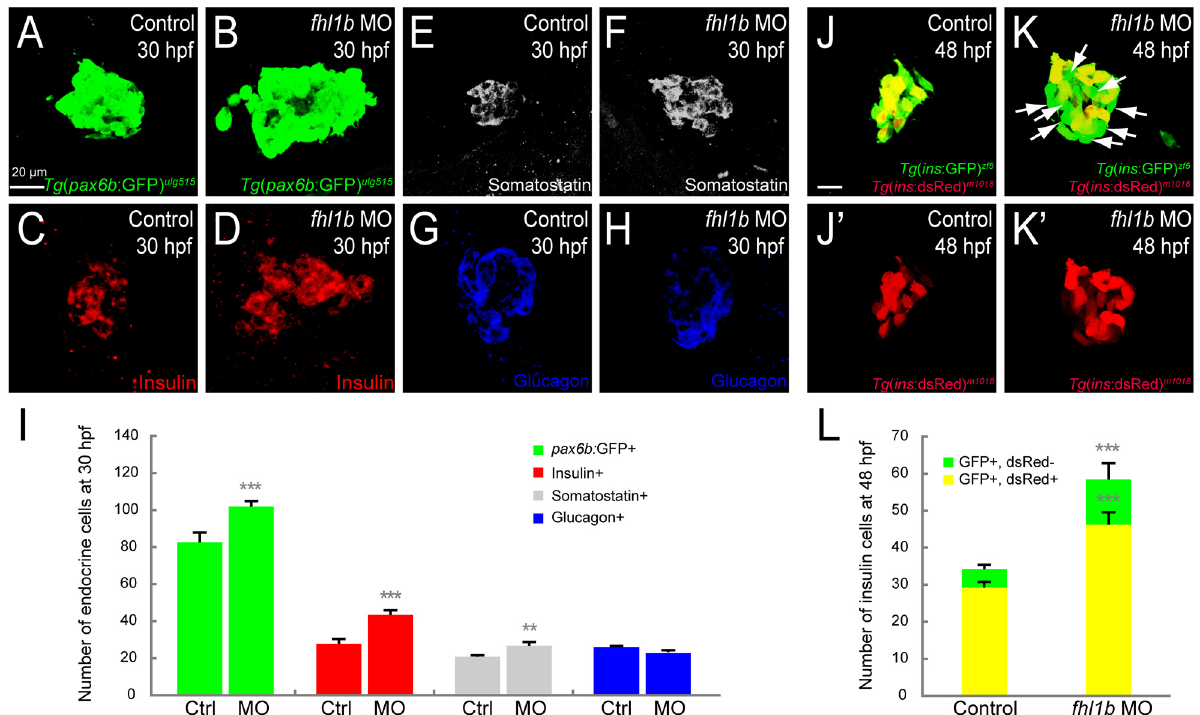
Fig 3. Decreased Fhl1b activity augments induction of pancreatic endocrine cells. (A-H) Confocal images showing Tg(P0-pax6b :GFP ) ulg515 (A and B, green), Insulin (C and D, red), Somatostatin (E and F, grey), and Glucagon (G and H, blue) expression at 30 hpf, comparing control embryos (A, C, E, and G) and fhl1b morphants (B, D, F, and H). The number of Tg(P0-pax6b :GFP ) ulg515 (B)- and Insulin (D)-expressing cells was significantly increased in fhl1b morphants compared to that of control embryos (A and C, respectively). The number of Somatostatin-expressing cells was also increased (F), while that of Glucagon-expressing cells appeared unaffected (H) in fhl1b morphants compared to that of control embryos (E and G, respectively). (I) Quantification of the number (mean ± SD) of total and individual pancreatic endocrine hormone-expressing cells, comparing that of control embryos and fhl1b morphants at 30 hpf. The absolute number of Tg(P0-pax6b :GFP ) ulg515 -, Insulin-, and Somatostatin-expressing cells was increased from 82.6 ± 4.5, 30.6 ± 1.5, and 20.7 ± 0.8, respectively, in control embryos, to 103 ± 2.0, 44.6 ± 2.0, and 26.7 ± 2.0, respectively, in fhl1b morphants, while that of Glucagon-expressing cells appeared unaffected (26.5 ± 0.7 cells in controls vs. 24.6 ± 1.5 cells in fhl1b morphants). Cells in 20 planes of confocal images from 5 individual embryos were counted. Asterisks indicate statistical significance: ** , P < 0.01; *** , P < 0.001. (J-K ’ ) Confocal images of Tg(ins : GFP) zf5 ;Tg(ins : dsRed) m1018 control embryos (J and J ’ ) and fhl1b morphants (K and K ’ ) at 48 hpf. Compared with the control embryos (J), fhl1b morphants showed an increased number of GFP-only-positive β -cells (K, white arrows). (L) Quantification of the number (mean ± SD) of GFP- and dsRed-double positive (yellow) and GFP-only-positive (green) β -cells, comparing that of control embryos and fhl1b morphants at 48 hpf. In control embryos, 5.0 ± 0.7 β -cells were GFP-only-positive, while 12.2 ± 2.3 β -cells were GFP-only- positive in fhl1b morphants. Cells in 20 planes of confocal images from 5 individual embryos were counted. Asterisks indicate statistical significance: *** , P < 0.001. A-H and J-K ’ , confocal projection images, ventral views, anterior to the top. Scale bars, 20 μ